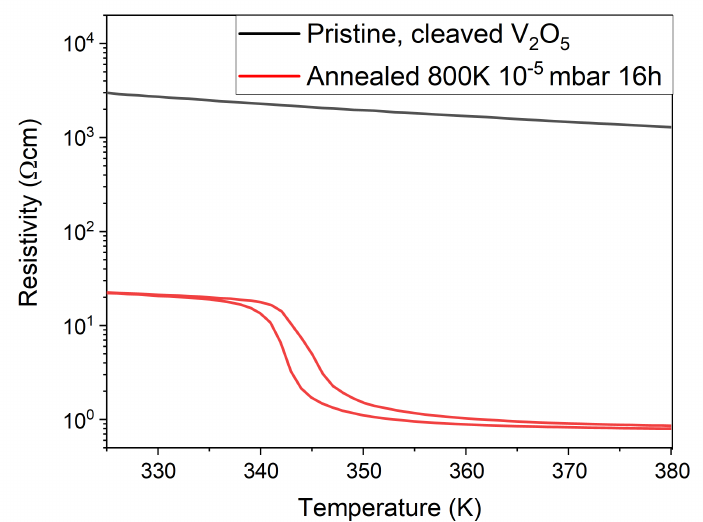
Figure 3. Resistivity as a function of temperature of the pristine crystal and the crystal annealed at 800K for 16h at 5 × 10 − 5 mbar. The VO 2 MIT is evident. The data is normalized to the resistivity of V 2 O 5